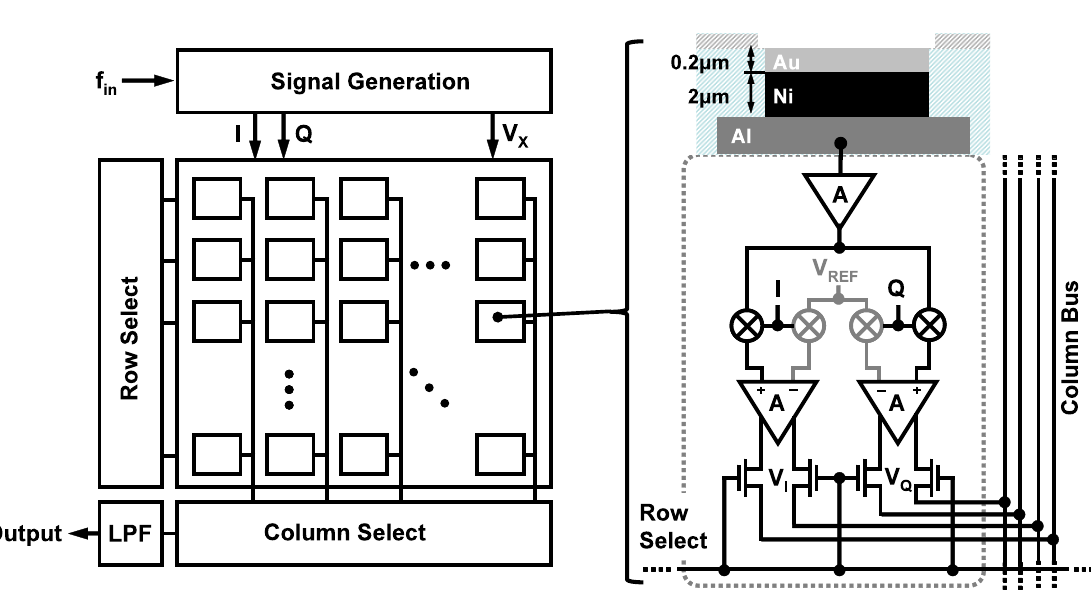
Figure 6. System